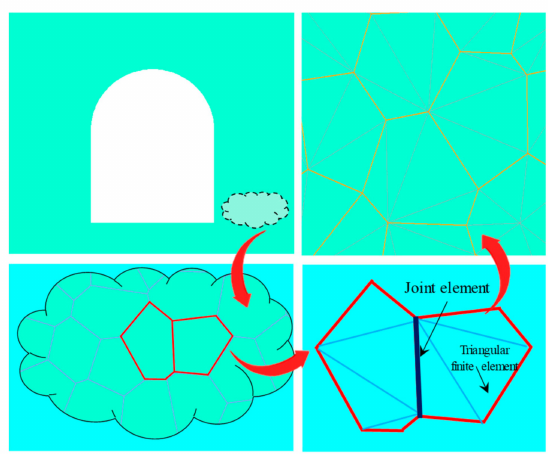
Figure 8. The surrounding rock of the chamber with Voronoi elements.